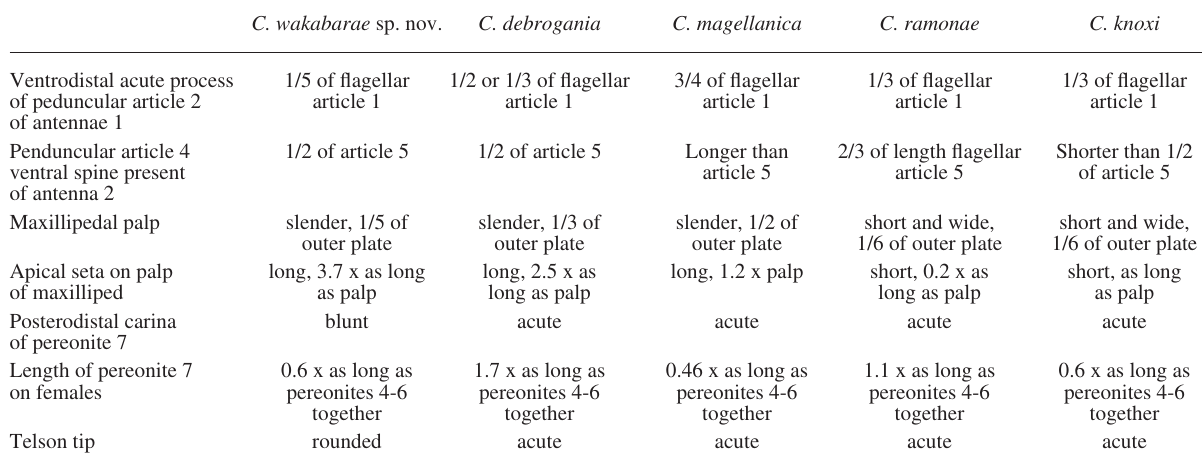
Table 1. – Comparison of selected characters of Curidia species. information was taken from text and figures included in thomas (1983), Coleman and Barnard (1991 b), lowry and Myers (2003) and Coleman and lowry